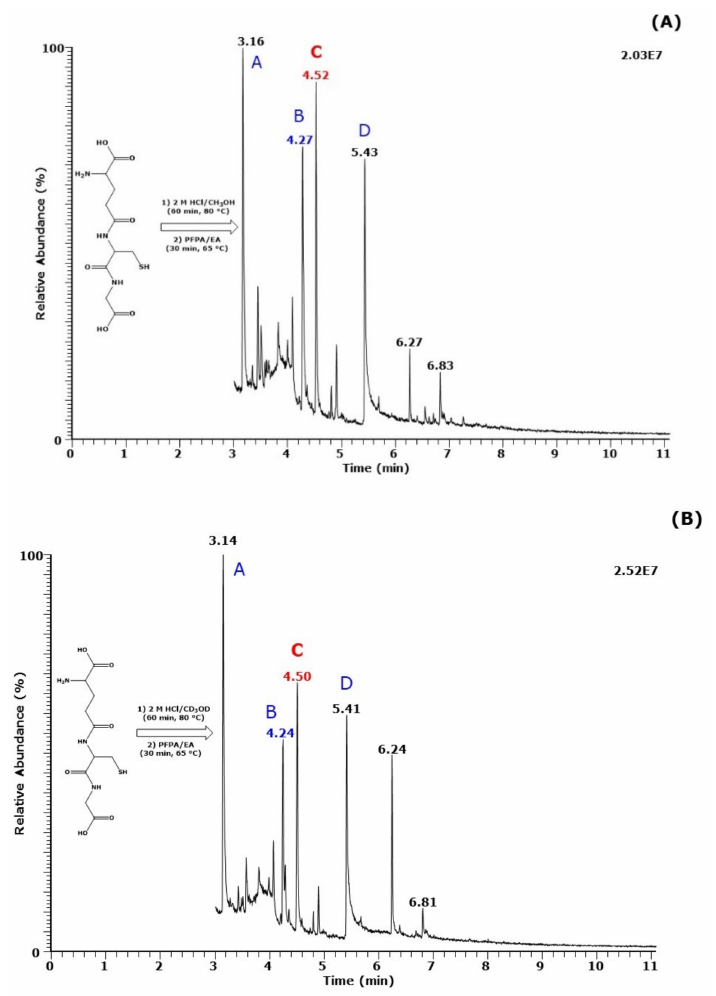
Figure 1. Total ion current GC-MS chromatograms in the ECNICI mode from separate analyses of glutathione (GSH, each 10 nmol) after its esterification (60 min, 80 ◦ C) in 2 M HCl/CH 3 OH ( A ) or 2 M HCl/CD 3 OD ( B ) and subsequent acylation with PFPA (30 min, 65 ◦ C). Oven temperature program TP#1 was used. Inserts indicate the chemical structure of GSH and the derivatization conditions. The quadrupole was scanned in the mass-to-charge ( m / z ) m / z -range 100–1000 (1 scan/s). The mass spectra of the peaks A, B, C and D are shown in Figure